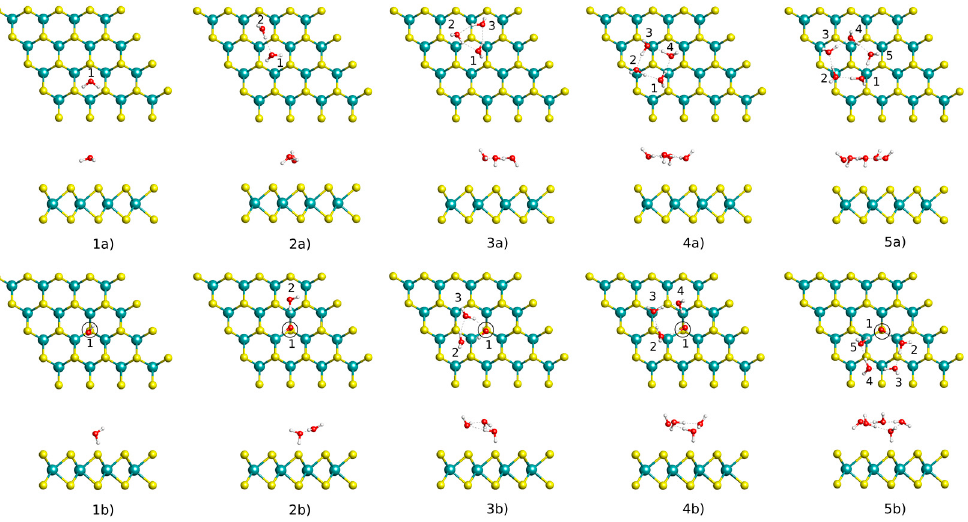
Figure 3. The most favorable configurations for (H 2 O) n ( n = 1–5) on the pristine and defective MoS 2 monolayers obtained by geometry optimization with the vdW-DF-CX functional. The notations of ( 1a – 5a ) and ( 1b – 5b ) correspond to the pristine and defective surface, respectively; numbers 1–5 correspond to the number of water molecules on the surface. The S defect is represented by the black circle. Table 1. The binding energy ( E bind ), adsorption energy ( E ad ), and equilibrium height ( h ) between the center of mass of the molecule and the top S-layer, total charge transfer ( ∆ Q) from MoS 2 to water cluster, and individual charge.